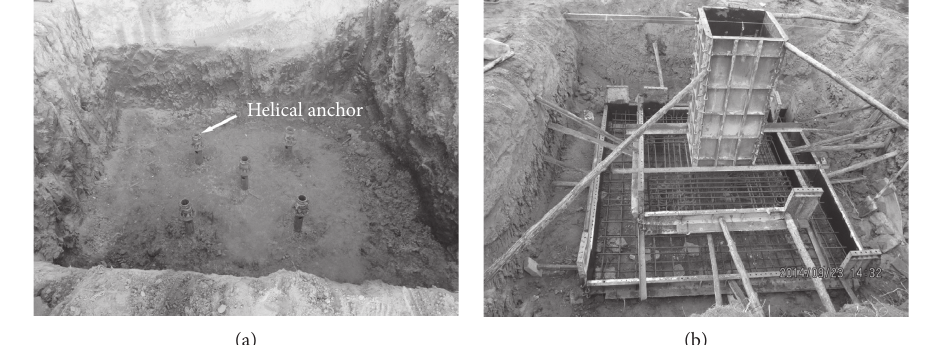
Figure 4: Photo of a composite foundation prior to concrete placement: (a) installed helical anchors and (b) the footing with reinforcement and supporting wall